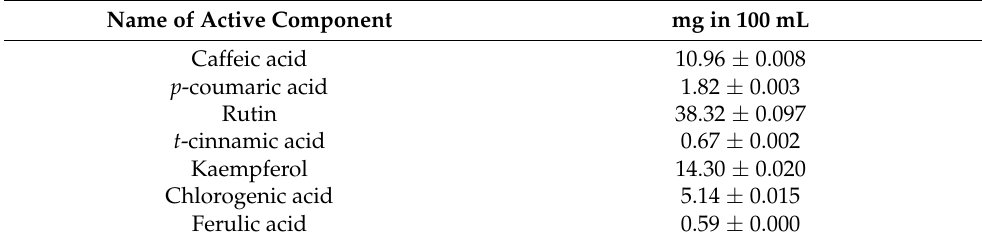
Figure 1. HPLC chromatogram of polyphenolic compounds in the ethanol extract of elder inflores- cences (Peaks: 1—caffeic acid; 2— p -coumaric acid; 3—rutin; 4—ferulic acid; 5—chlorogenic acid; 6— t -cinnamic acid; and 7—kaempferol). Table 5. Content of the polyphenols identified in the 70% ethanol extract obtained from freeze-dried elder inflorescences (SE ±, n = 4).